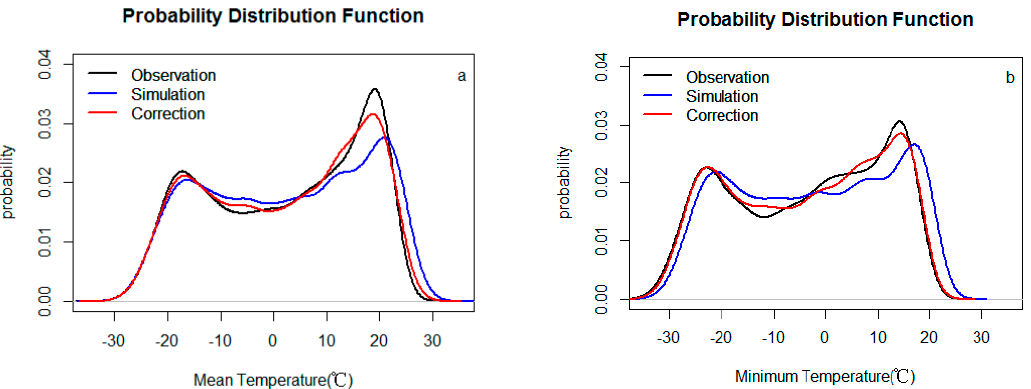
Figure 3. Probability distribution functions (PDFs) of the T mean and T min for observation, simulation and correction during the baseline period: ( a ) PDFs of the T mean for observation (black line), simulation (blue line), and correction (red line); ( b ) PDFs of the T min for observation (black line), simulation (blue line) and correction (red line).